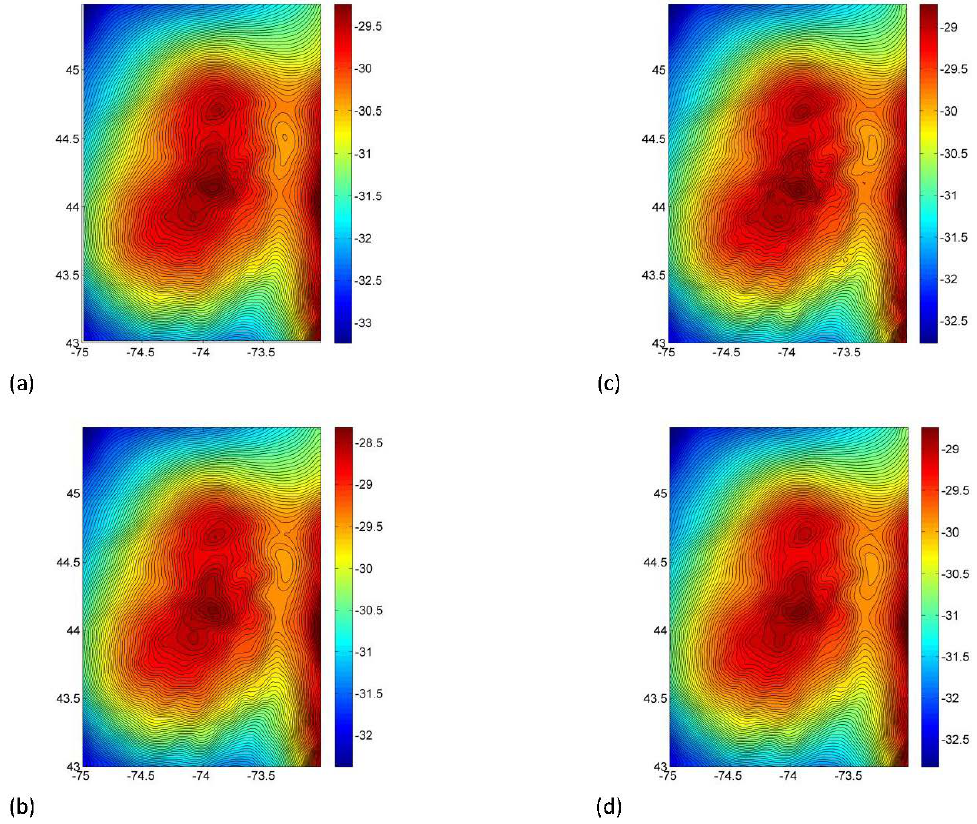
Figure 15: The GMS (a) and QGMS (b) geoid vs. USGG12 (c) and CGG13 (d) geoid for the New Hampshire test area in 5 cm contours.